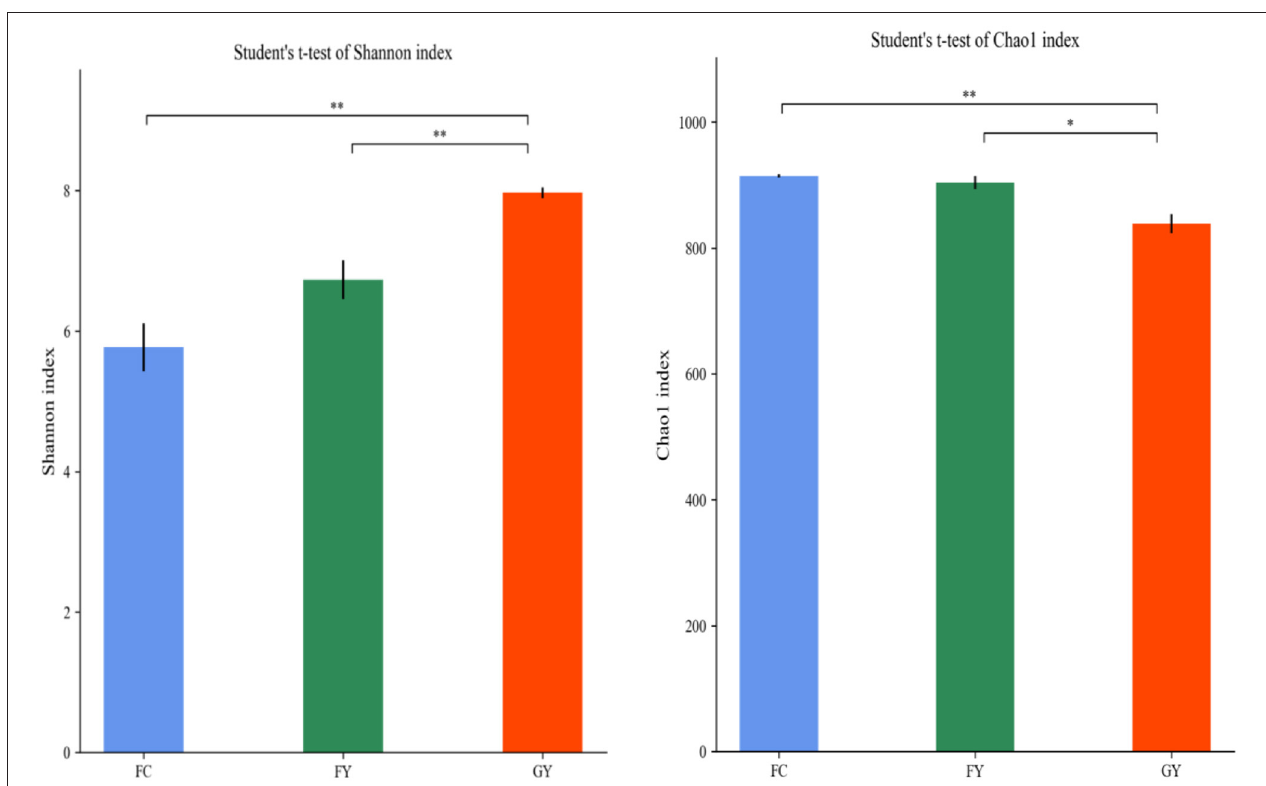
FIGURE 3 | Ruminal bacteria diversity of GYs, FC, and FYs. * P < 0.05; ** P < 0.01.